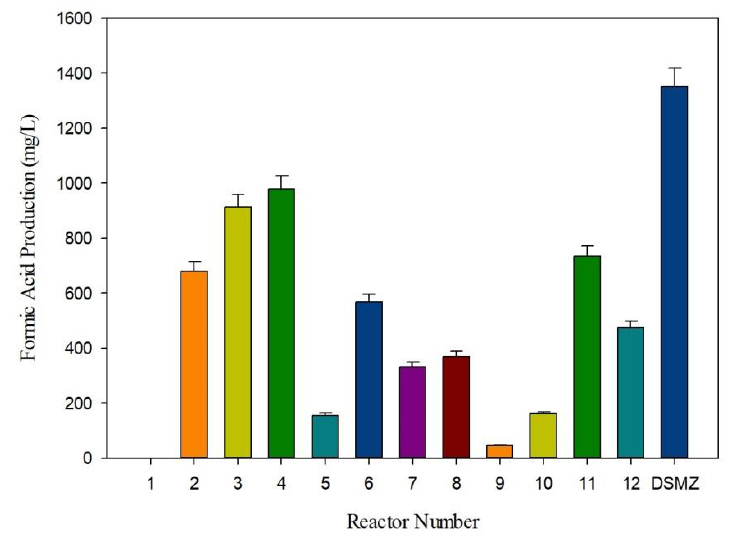
Figure 2. Formic acid production in different experimental trials.